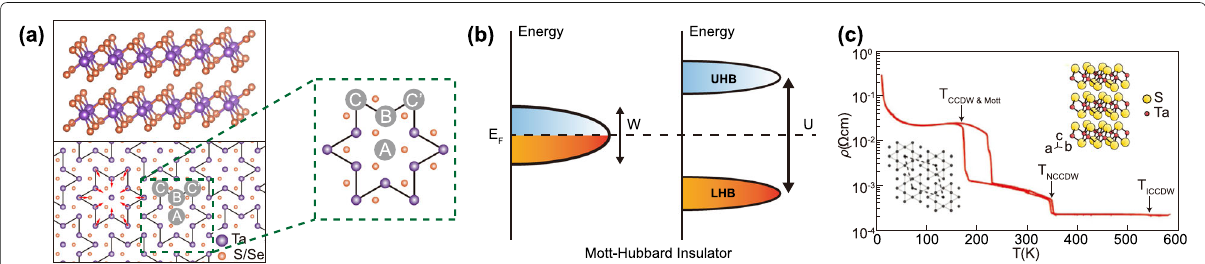
Fig. 1 Structural and electronic properties of bulk 1 T -TaS 2 and 1 T -TaSe 2 . a Atomic structure and top-view diagram of the SD superlattice. An enlargement of the SD cluster is shown in the green dashed box. b Schematic diagram of the Mott-Hubbard Insulator. c CDW phase transition diagram of 1 T -TaS 2 . Taken from ref. [8,